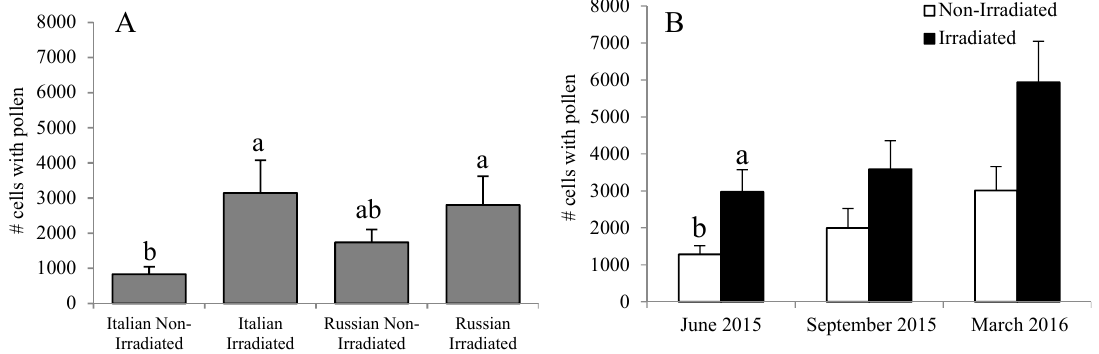
Figure 7. Amount of pollen stores in Russian and Italian honey bee colonies containing irradiated or non-irradiated combs ( A ) overall or ( B ) over the season. Bars with the same letters are not significantly different ( p >0.05).